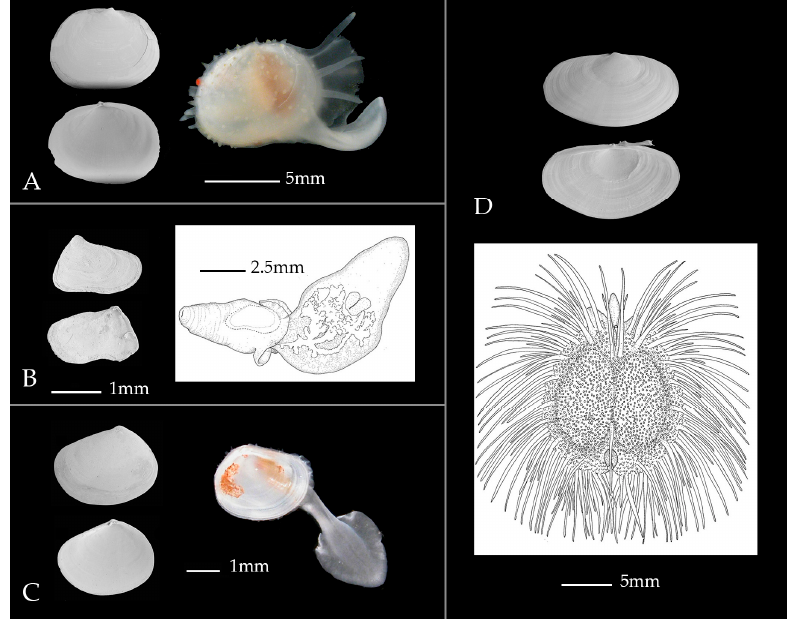
Figure 4. Simple shells and complex animals in species of Galeommatoidea from Eastern and Northeastern Australia. ( A ) Scintilla anomala ; ( B ) Entovalva sp.; ( C ) Austrodevonia sharnae ; and ( D ) Ephippodontomorpha hirsutus .